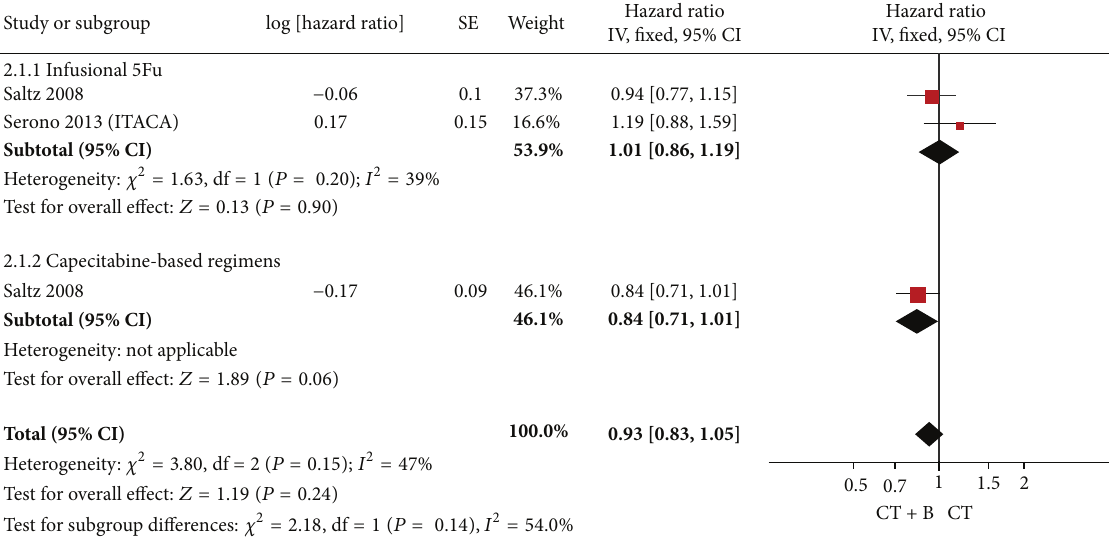
Figure 3: Fixed effect model on HR of OS in the most used combination chemotherapy. The pooled HR of OS in standard first-line chemotherapy is symbolized by a solid diamond at the bottom of the forest plot and the width of which represents the 95% CI.